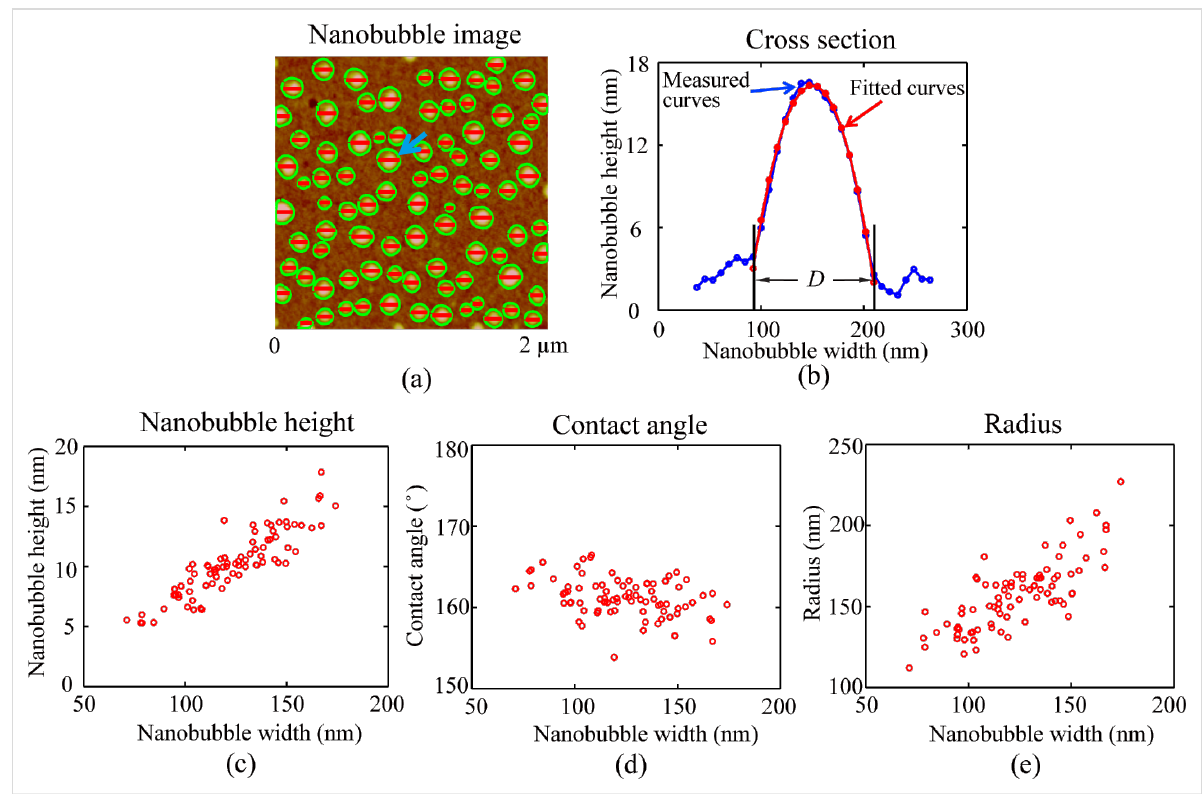
Figure 9: Morphological characterization of NBs detected with the proposed method. (a) Automated extraction of the NB cross sections after image segmentation. (b) Cross section of the NB indicated by the blue arrow in (a) and a corresponding least squares fit curve by fitting the profile as a circular arc. (c–e) The height, contact angle, and radius of curvature as a function of width for all detected NBs in the AFM image, respectively. The NB height and radius of curvature increase with width, while the contact angle decreases with